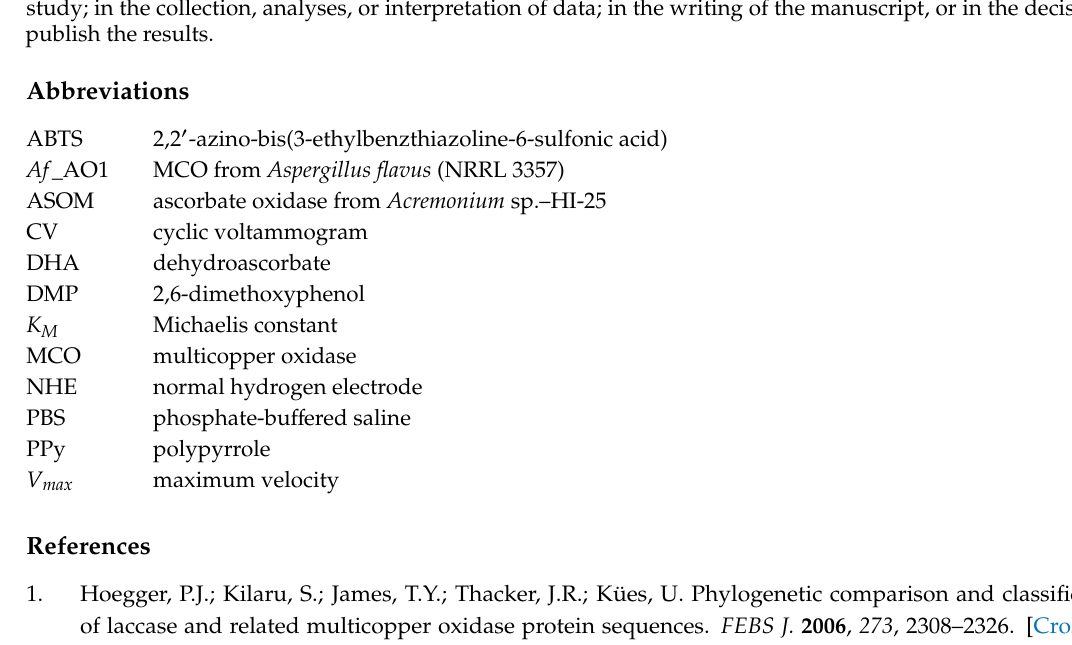
Figure S1: Wavelength scan of Af _AO1 compared to known laccases, Figure S2: Substrate screening, Figure S3: Kinetic parameters of Af _AO1, Figure S4: Stability of Af _AO1, Figure S5: Alignment Af _AO1 with ascorbate oxidase from Cucurbita pepo var. melopepo (1ASQ), Figure S6: Homology model in cartoon representation compared to the template (PDB-Code 1ASQ), Figure S7: SDS-PAGE of purified and deglycosylated Af